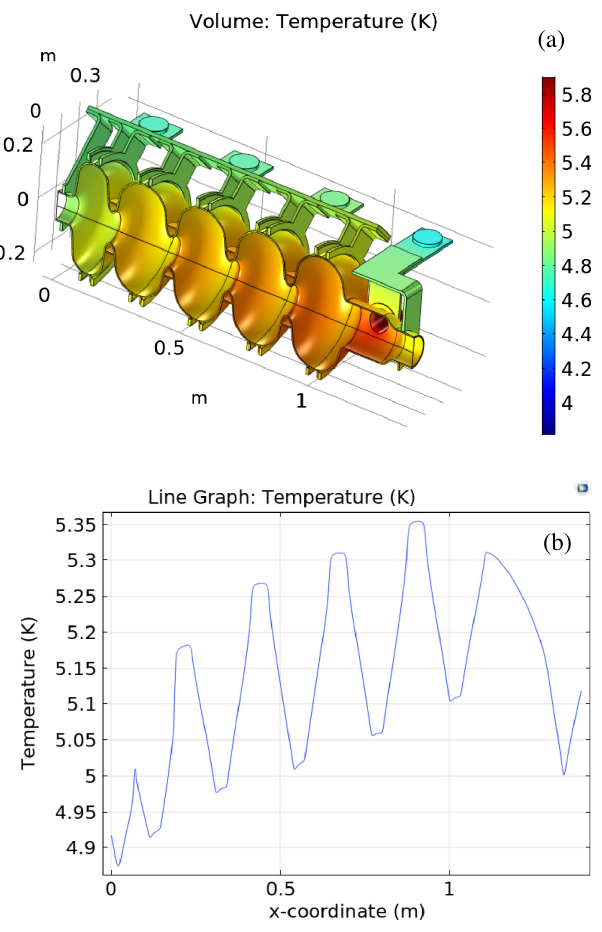
FIG. 21. Steady-state cavity temperature profile for 10 MeV, 100 mA operation (a) surface temperature map and (b) line graph along the cavity wall profile.